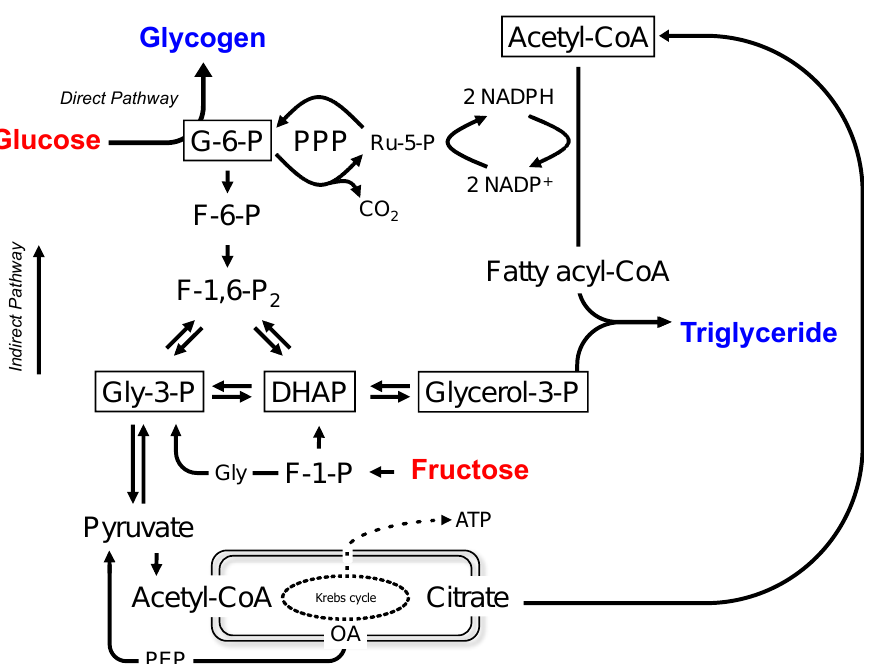
Figure 1. Metabolic model for the synthesis of glycogen and triglyceride from glucose or fructose in the liver. The model includes glucose-6-phosphate oxidation by the pentose phosphate pathway (PPP) to provide NADPH for conversion of acetyl-CoA to fatty acyl-CoA via de novo lipogenesis. The 13 C-enriched glucose and fructose precursors are highlighted in red and the sampled metabo- lites, glycogen and triglyceride, are highlighted in blue. The metabolite pools whose 13 C and 2 H enrichments are reported by the sampled metabolites, namely, glucose-6-P, triose-P (dihydroxy- acetone phosphate and glyceraldehyde 3-phosphate) and lipogenic acetyl-CoA, are highlighted in boxes. Glycogen synthesis from glucose via glucose-6-P from gluconeogenic precursors, including pyruvate and triose-P sources, is also indicated (direct and indirect pathways, respectively). For simplicity, some metabolic intermediates, as well as ATP/ADP and NAD/NADH interconversions, are not shown. Abbreviations are as follows: DHAP — dihydroxyacetone phosphate; F-1-P — fructose-1-phosphate; F-6-P — fructose 6-phosphate; F-1,6-P 2 — fructose-1,6-bisphosphate; G-6-P — glucose 6-phosphate; Gly — glyceraldehyde; Gly-3-P — glyceraldehyde 3-phosphate; OA — oxaloacetate; PEP — phophoenolpyruvate; Ru-5-P: ribulose-5-P.